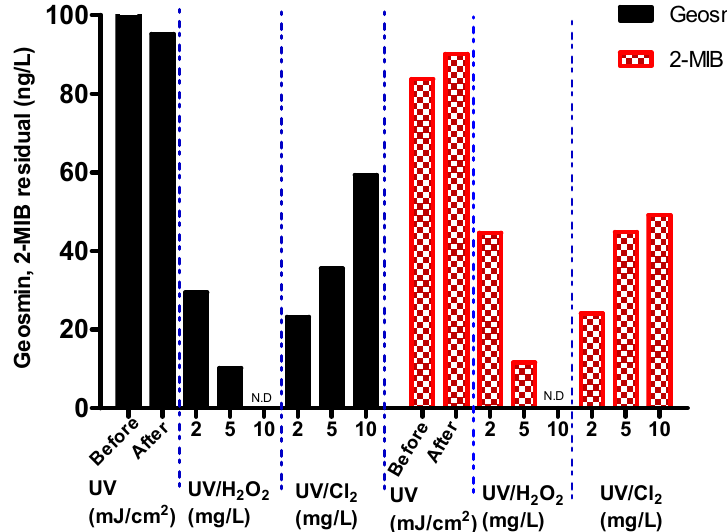
Figure 10. Degradation of geosmin and 2-MIB by UV, UV/H 2 O 2 , and UV/Cl 2 processes in the pilot-scale test (PMC dose: 20 mg/L; UV dose: 871.8 mJ/cm 2 ; Cl 2 dose: 2, 5, and 10 mg/L; H 2 O 2 dose: 2, 5, and 10 mg/L).